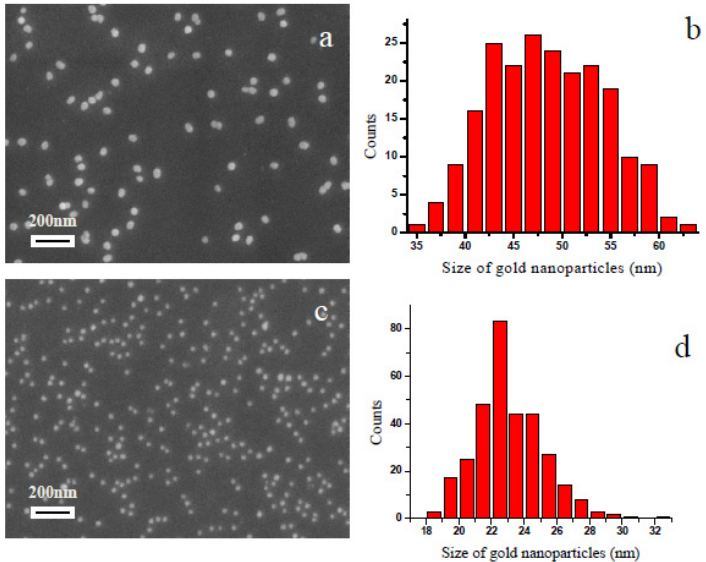
Figure 19. ( a ) and ( c ) SEM images of the AuNPs assembled into LbL films; ( b ) and ( d ) Size distribution of the synthesized Au NPs. Reprinted with permission of [73].